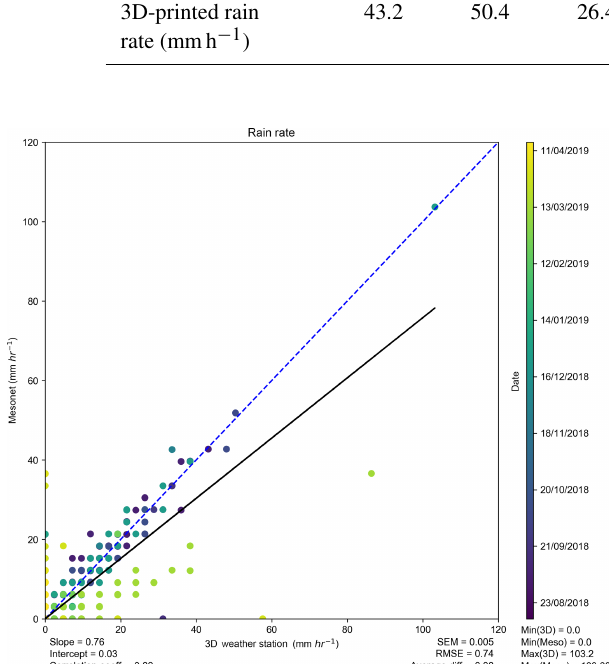
Figure 13. Comparison of precipitation rates for the 3D-printed tip- ping bucket rain gauge using a Hall effect sensor ( x ) and the Okla- homa Mesonet ( y ) for the entire deployment, color-coded by time. The one-to-one reference line (blue dashed) and linear regression line (black solid) are